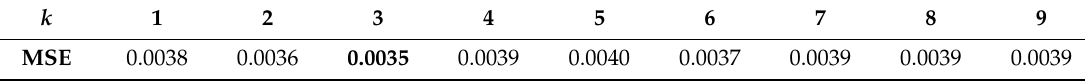
Figure 7. Architecture of Convolutional Self-Attention Long Short-Term Memory (LSTM) model . Table 2. MSE (Mean Square Error) by k values. ( The value in bold is the minimum value. ).